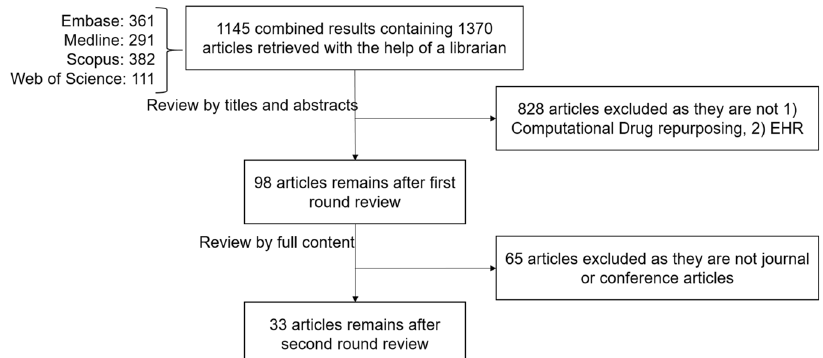
Fig. 6 Flow chart for article selection and fi